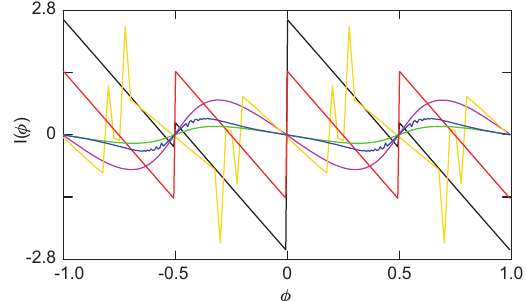
Figure 16 Persistent current as a function of fl ux φ for a half-fi lled mesoscopic cylinder taking N = 15 and M = 2 in the presence of NNH and SNH integrals. The black line corresponds to the ordered case when U = 0, whereas the magenta and gold lines correspond to the disordered case ( W = 2) when U = 0 and 1.5, respectively. Here, SNH integral is fi xed at -0.8. The currents shown by the red, green, and blue lines for the ring described with NNH model (identical to Figure 14) are re-plotted to judge the effect of SNH integral over NNH model much